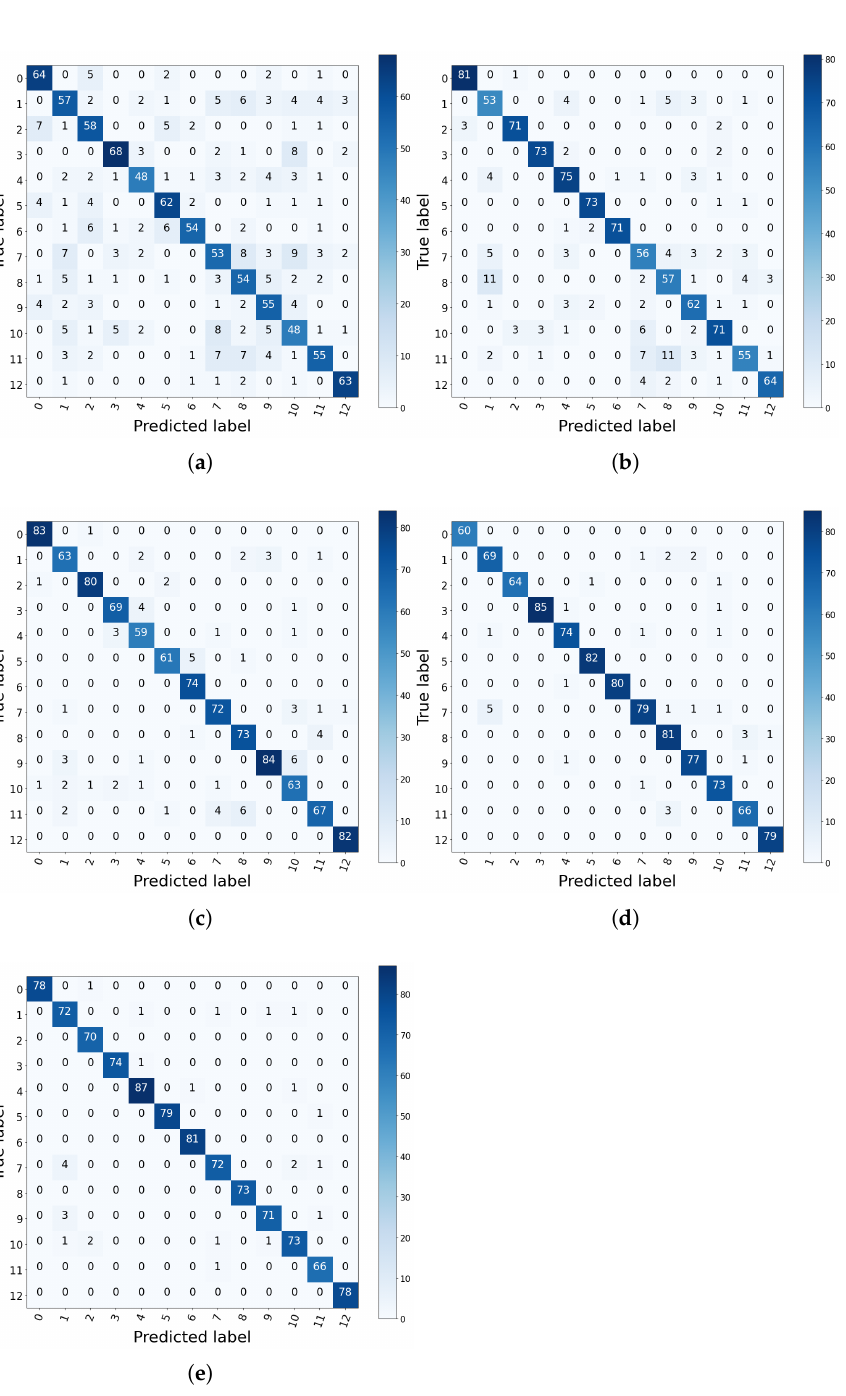
Figure 7. Confusion matrix of the result on each method with PU dataset. ( a ) MLP; ( b ) CNN; ( c ) SimpleIMSCNN; ( d ) MSCNN ( e );